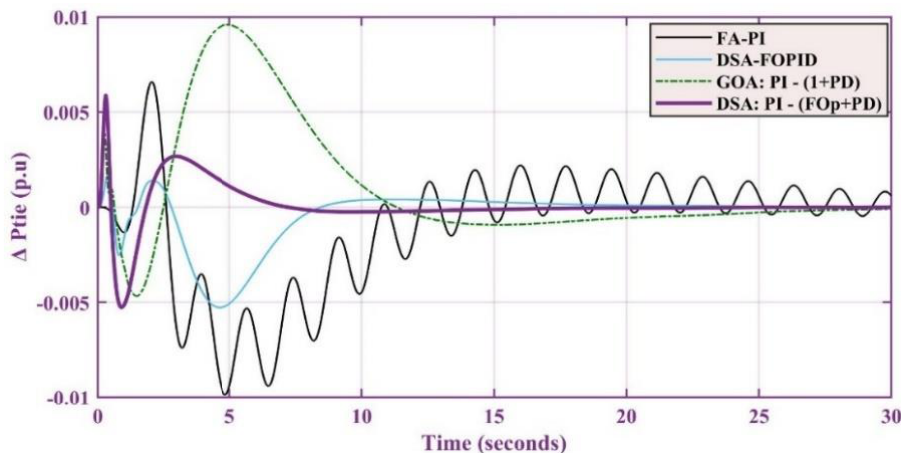
Figure 11. Tie-line power exchange response at 2.5% load change.